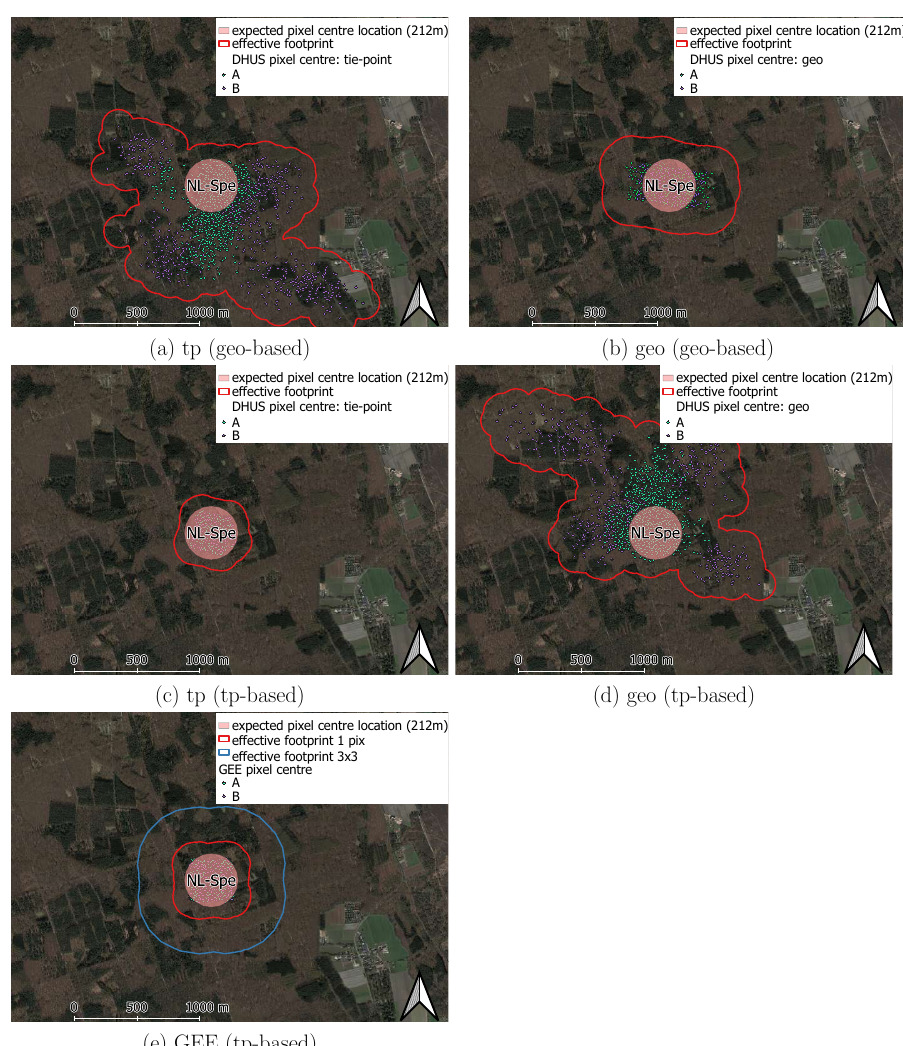
Figure 2. The effective ground footprint of Sentinel-3 OLCI dataset at Speulderbos site from DHUS images (red polygon). The pink circle is the 212 meter radius circle of the theoretically expected pixel center location. The points show the actual OLCI pixel center location of Sentinel-3A (green) and Sentinel-3B (purple) spacecrafts. The footprint was calculated based on ( a ) tie-point coordinates, corresponding to ( b ), ( b ) geo-coordinates (standard SNAP extraction), ( c ) tie-point coordinates (modified SNAP extraction), and ( d ) geo-coordinates corresponding to ( c ), ( e ) GEE coordinates (reported to be tie-point